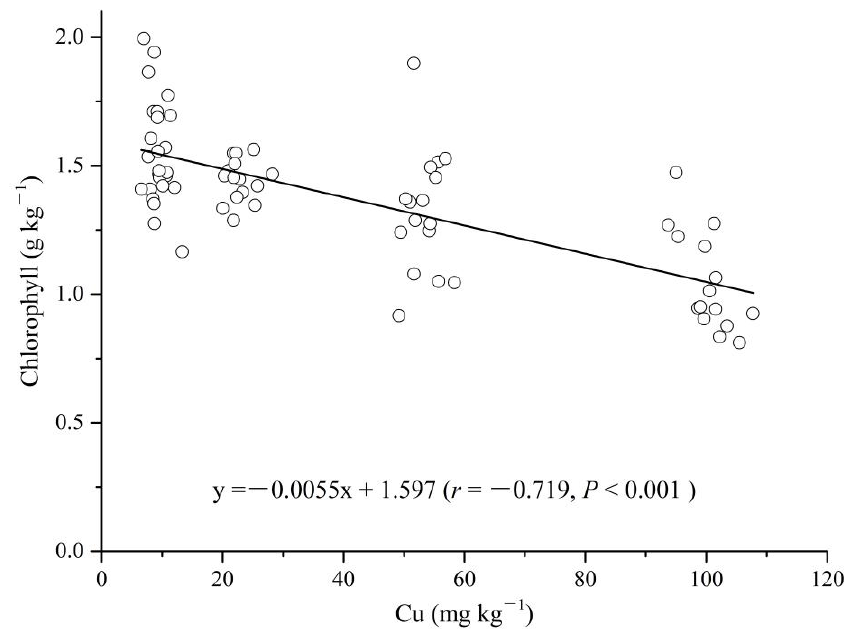
Figure 4. Relationship between foliar Cu and chlorophyll concentration ( N =